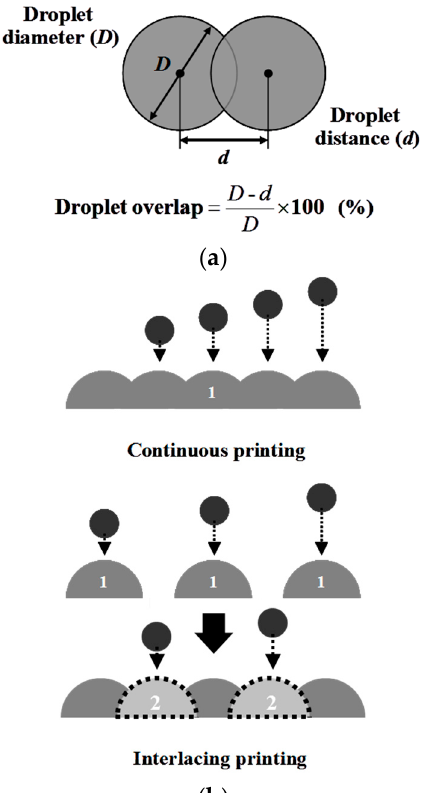
Figure 1. Schematic diagrams of ( a ) droplet overlap as the ratio between neighboring droplets and ( b ) different modes of a printing procedure to form a continuous line.